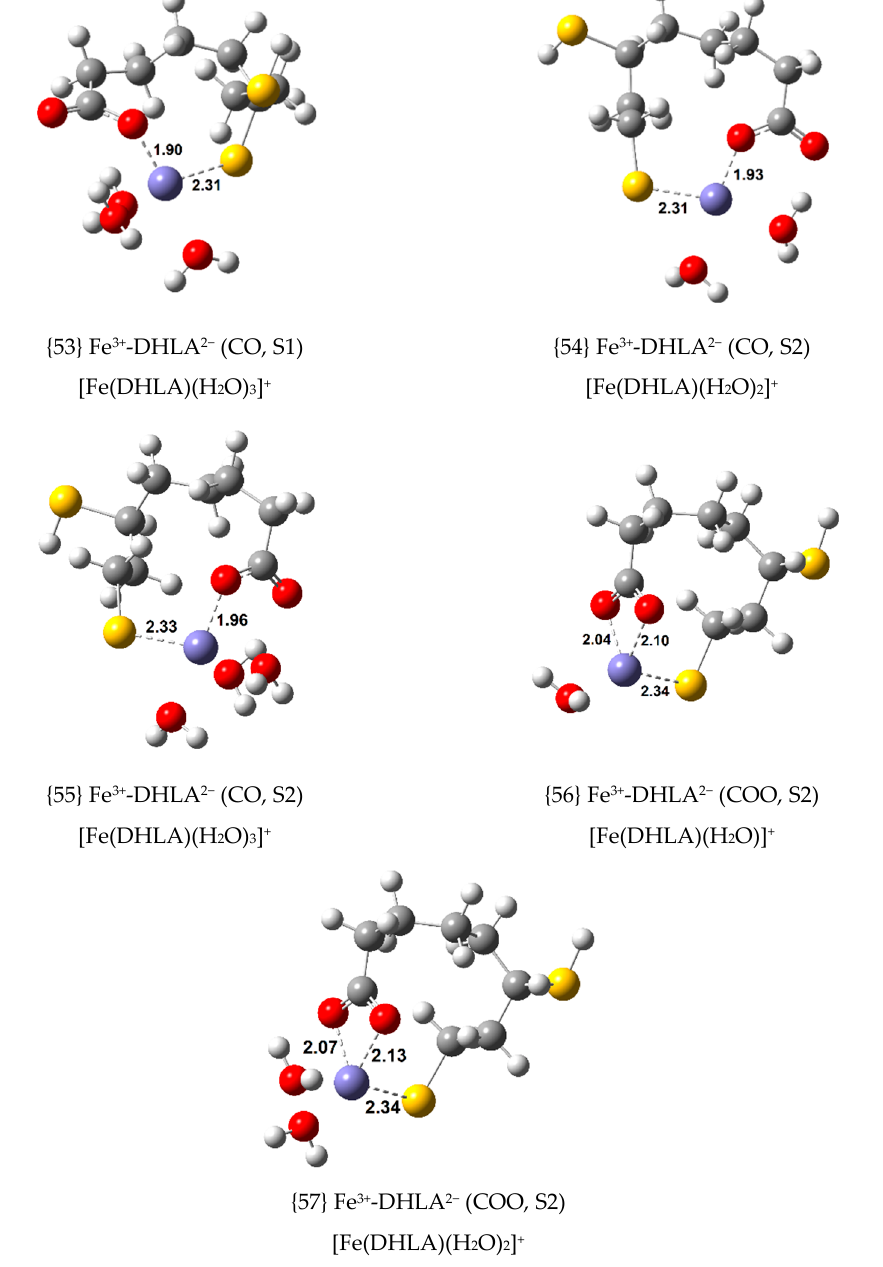
Figure 7. Optimized geometries of non-octahedral 1:1 complexes of Fe(III) with S1- and S2-deprotonated DHLA 2 − (bond distances in Å). Table 4. Standard Gibbs free energy change ( ∆𝐺 (cid:2916)° , in kcal/mol) and formation constant ( 𝐾 (cid:2916) , log𝐾 (cid:2916) ) for the non-octahedral chelation of Fe(III) with LA − (as per Equation (4)), and with S1- and S2-deprotonated DHLA 2 − (as per Equation (7)) in aqueous solution at 298.15 K. a